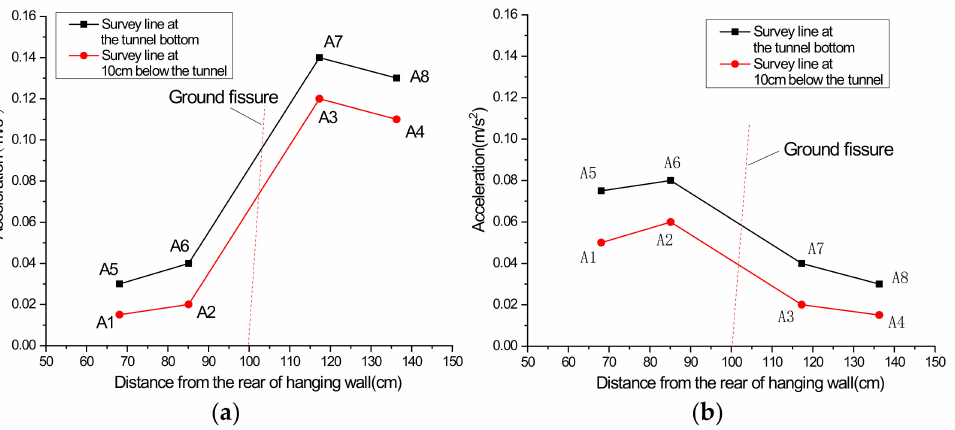
Figure 15. Peak acceleration curves under the combined impact of hanging wall descending (1 cm) and 10 Hz excitation: ( a ) vibration exciter at 60 cm; ( b ) vibration exciter at 100